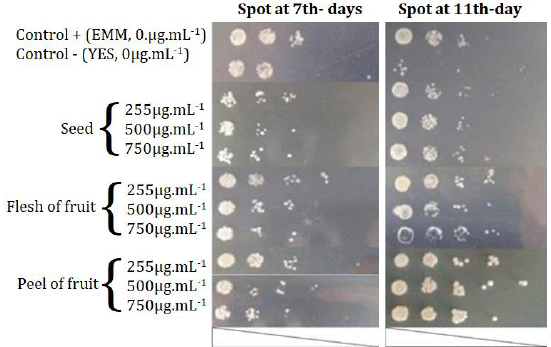
Figure 2. The effect of phytoextracts derived from the generative organ parts of X. granatum on the viability of S. pombe cells. All extract could promote yeast survival rate at stationary phase (7 and 11 days of incubation) compared to that without extract treatment. Yeast was grown in YES medium supplemented with various concentrations of